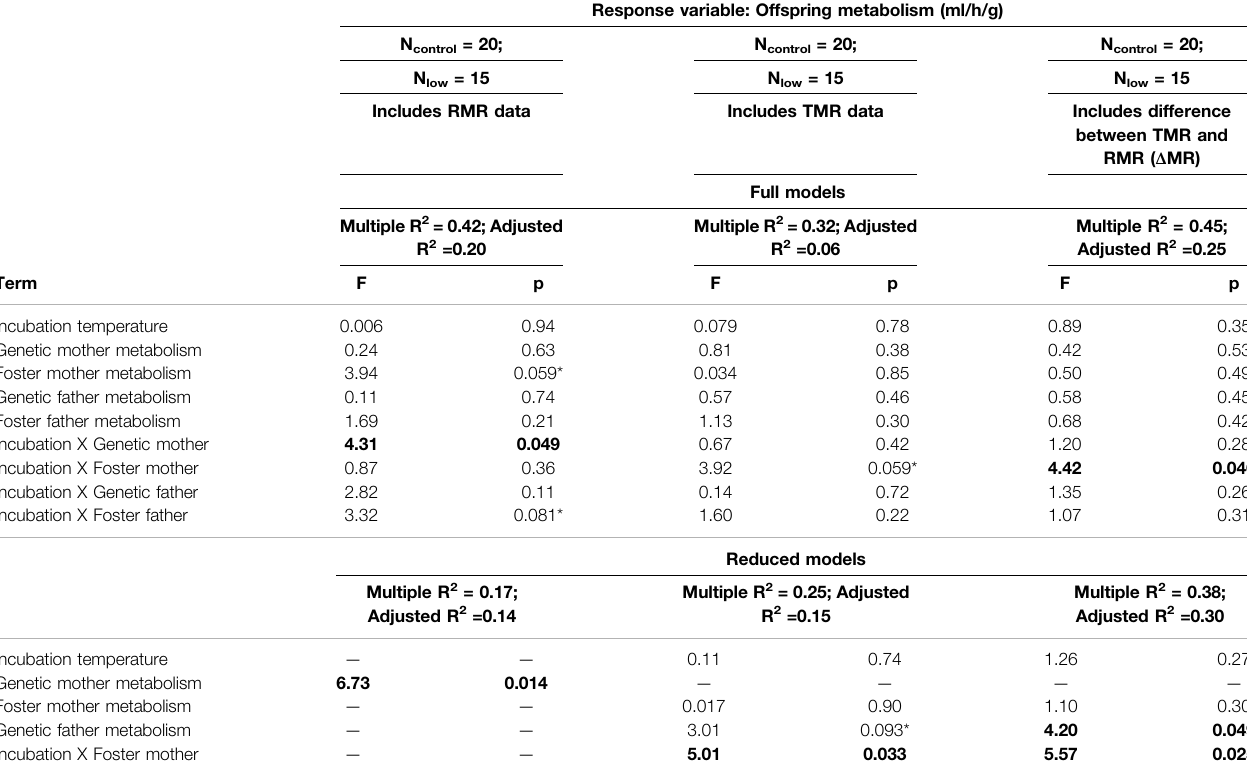
TABLE 4 | Full and reduced models investigating the relationship of offspring metabolism at Day 30 with interactions between incubation temperature and parental metabolism.